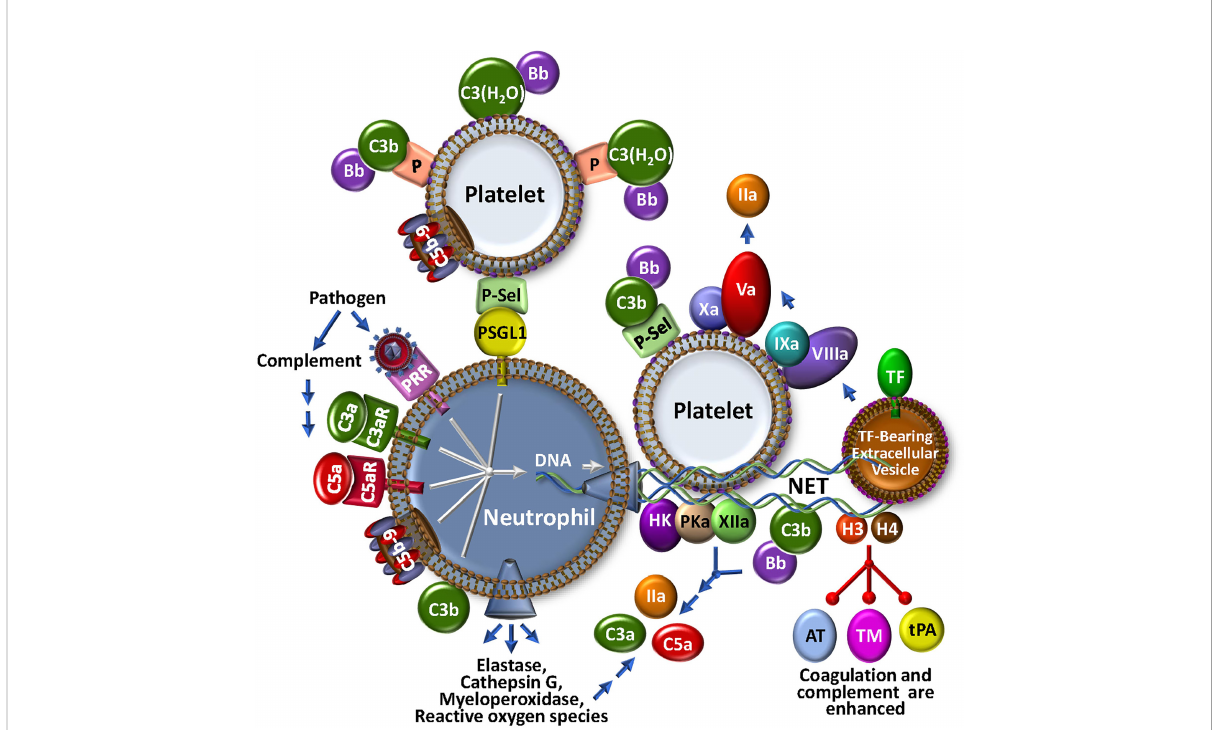
FIGURE 3 The NETosis-Coagulation-Complement Web. Neutrophils release NETs after binding of foreign particles to pathogen recognition receptors (PRR), engagement of complement anaphylatoxic or opsonic species, or association of P-selectin on activated platelets with P-selectin glycoprotein 1 (PSGL1). Stimulated neutrophils release numerous bioeffectors including neutrophil elastase, cathepsin G, myeloperoxidase and reactive oxygen species, which may affect production of coagulation and complement bioeffectors directly or indirectly through cell modulation. Release of DNA-based NETs from neutrophils, provides a complex matrix for interactions with stimulated platelets and localizes TF activity, possibly by trapping extracellular vesicles. Both coagulation and complement pathways are further propagated by direct protein factor association with NETs through the contact and alternative pathways, respectively. Multistep crosstalk between these pathways results in further generation of thrombin, C3a and C5a with potential for biological consequence. Histones, H3 and H4, are major protein constituents of NETs and enhance coagulation and complement by inhibiting the regulators, antithrombin (AT) and thrombomodulin (TM), and stabilize the clot by attenuating tPA-mediated fi brinolysis. The activated platelet surface is typically regarded as procoagulant because it provides anionic phospholipid (purple polar head groups), but platelet-bound P-selectin and properdin (P) also stabilize AP C3 convertase assembly via association with C3b and C3(H 2 O), respectively. The platelet surface may also associate directly with C3(H 2 0) toward complement